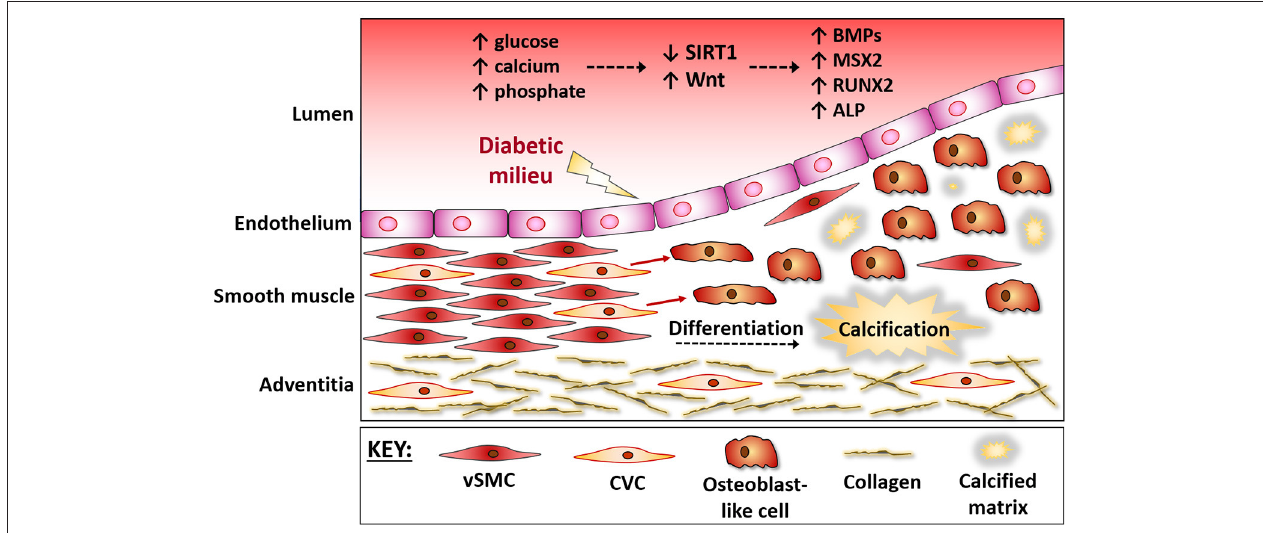
FIGURE 1 | The vessel wall during osteogenic differentiation. The vessel wall responds to the micro-environment within the circulation. During diabetes hyperglycaemia and mineral ion imbalances lead to endothelial damage. The medial layer then responds via triggering a repair response, which often gets masked and further damage ensues. Progenitor cells within the media, often referred to as calcifying vascular cells (CVCs), are believed to up-regulate osteogenic factors and differentiate into bone-forming osteoblasts that contribute to vessel stiffening. These vascular progenitor cells directly sense extracellular signals, including a down regulation of SIRT1 and activation of Wnt signaling, and the protective mechanisms are over-ridden, causing a differentiation of CVCs into bone-forming osteoblasts. BMPs, Bone Morphogenic Proteins; MSX2, msh homeobox 2; RUNX2, Runt related transcription factor 2; OCN, Osteocalcin; CVC, Calcifying Vascular Cells; vSMC, vascular Smooth Muscle